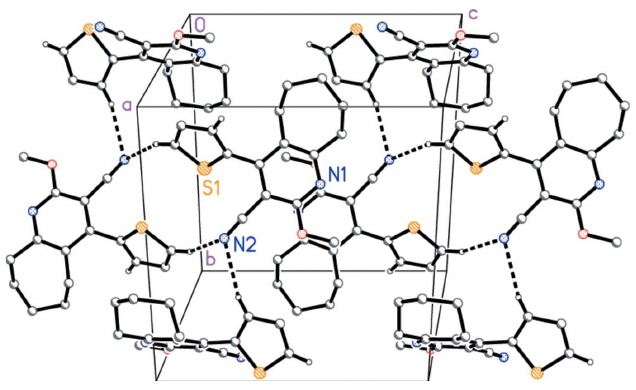
Figure 6 Part of the three-dimensional molecular packing of compound 1b , viewed perpendicular to (110), showing the ‘weak’ hydrogen bonds (drawn as dashed bonds). Atom labels indicate the asymmetric unit. Two inversion- symmetric substructures are shown, each with two further molecules related by the 2 1 axis.